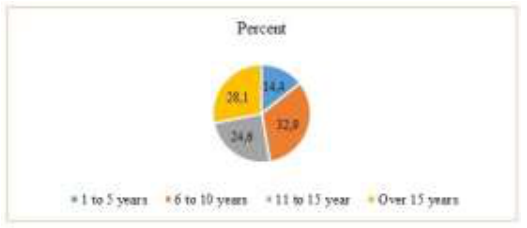
Figure 1. Indicating Respondents Work Experience